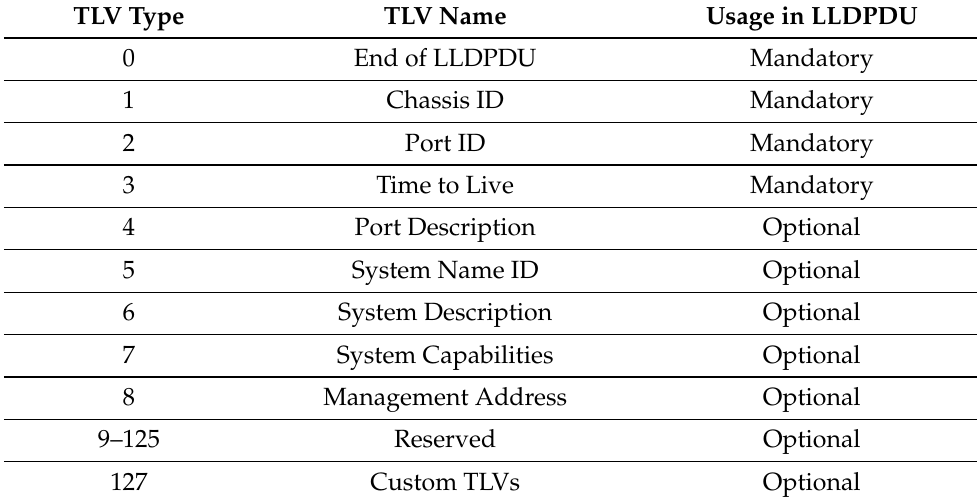
Table 2. TLV type values. Adapted from [18].